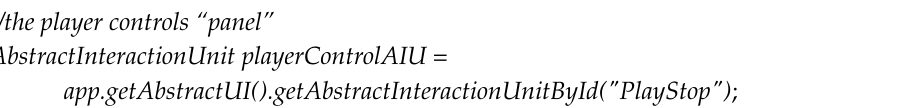
Algorithm 2. Control Logic code required to set the business logic actions that must be called when the user triggers the actions to start playing music in the EMP